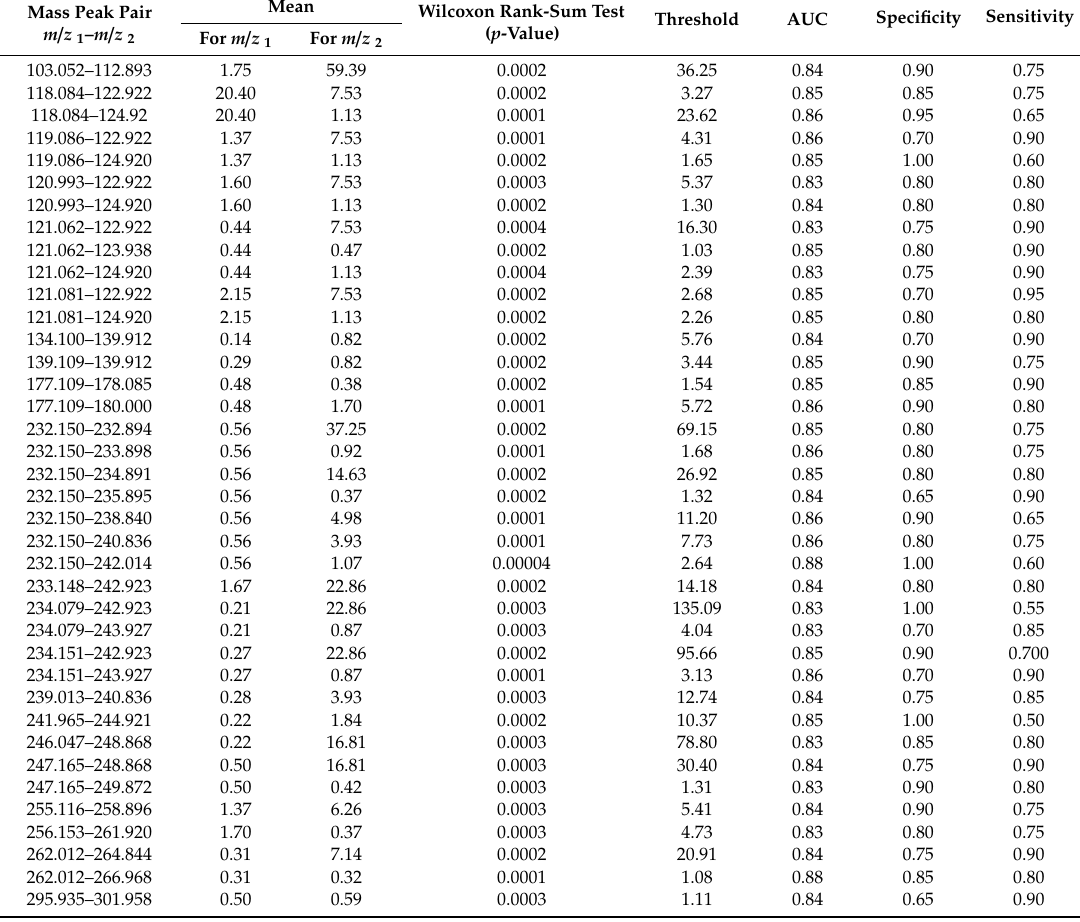
Table 2. Data related to the label-free diagnostic